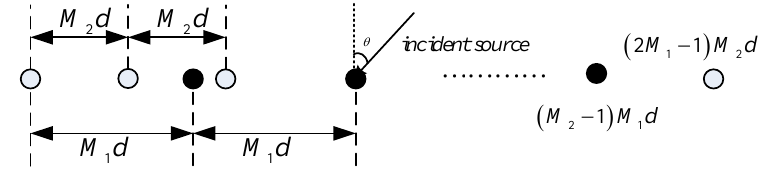
Figure 1. Extended coprime array